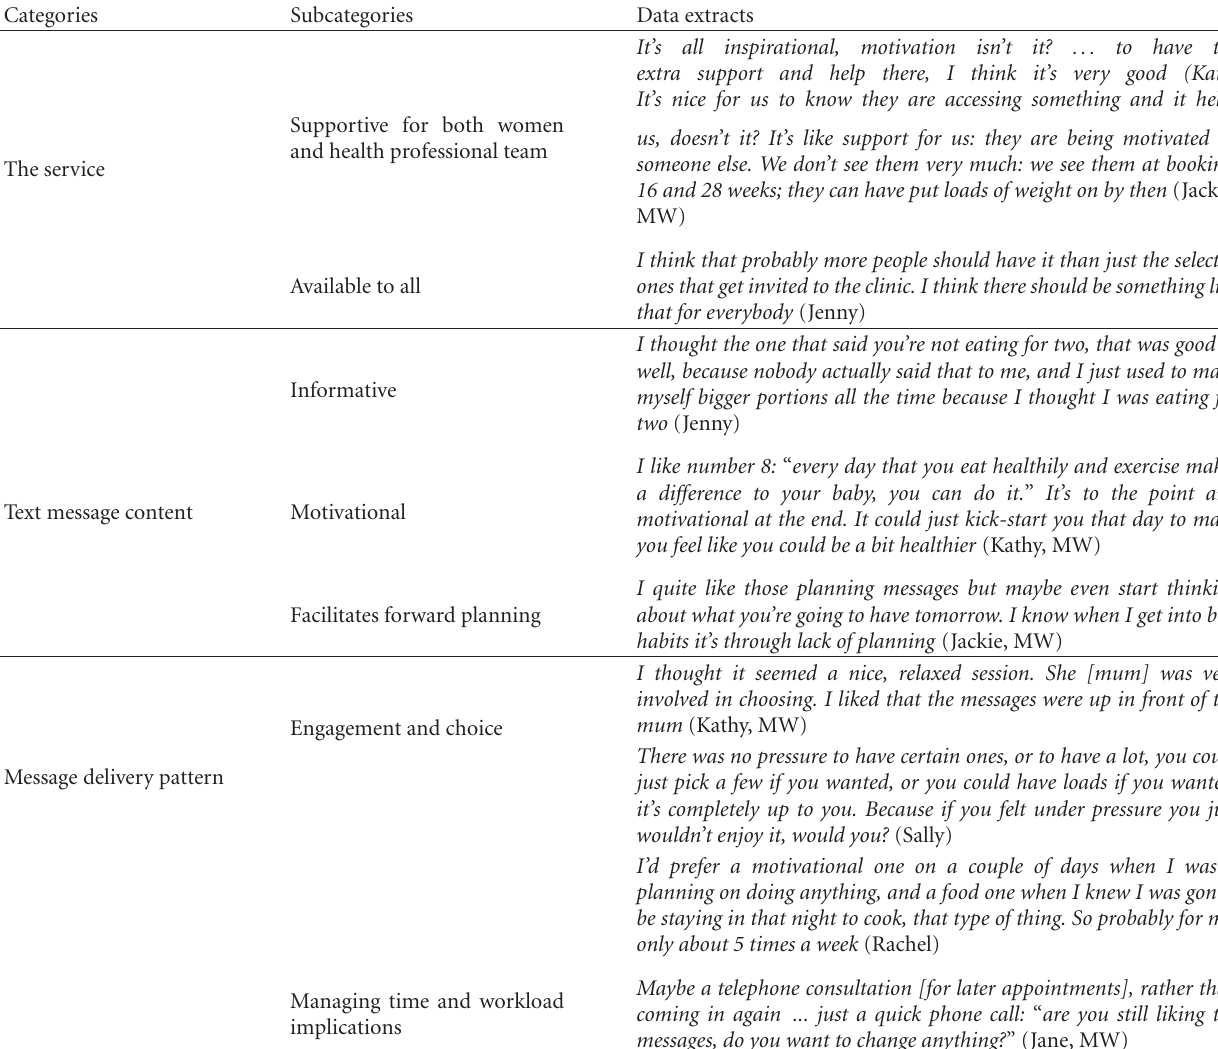
Table 3: Results from the second focus group on the proposed text messaging service in support of obesity management in pregnancy.